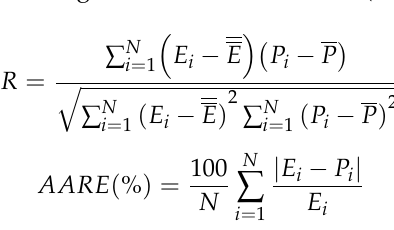
Figure 6. A comparison between the experimental and predicted true stress for the Fe-35Mn-10Al- 1C steel at a strain rate of 0.1 s − 1 ( a ), 1 s − 1 ( b ), 10 s − 1 ( c ), for the whole dataset ( d ) and for peak stress values ( e ).